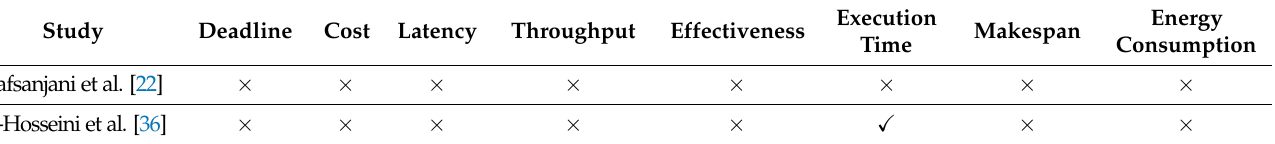
Table 13. Analysis of articles in terms of evaluation parameters in smart building